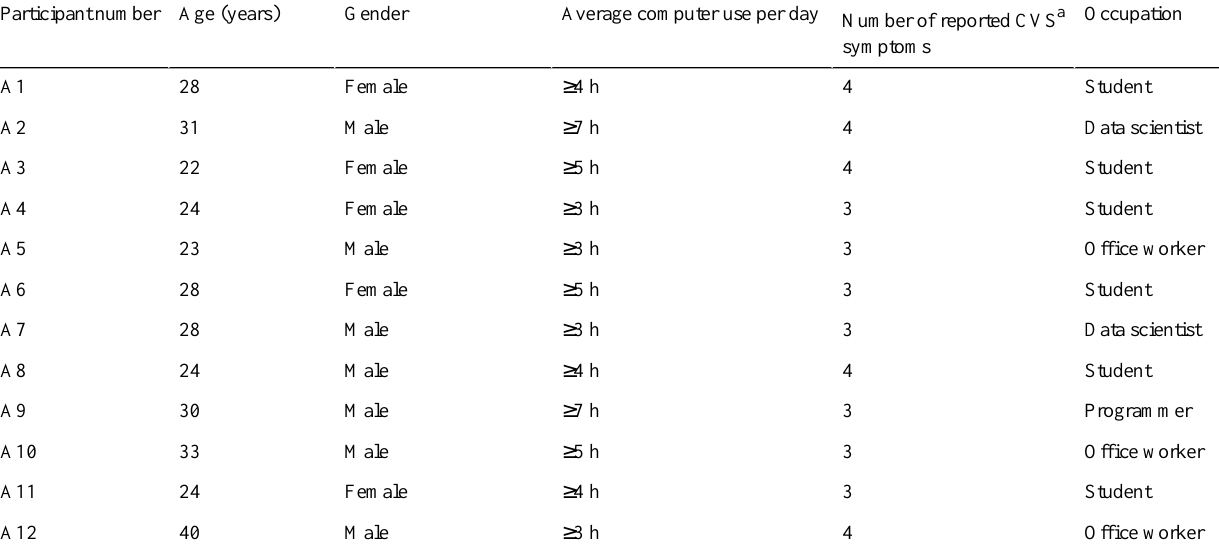
Table 2. Information of the participants in the 14-day deployment